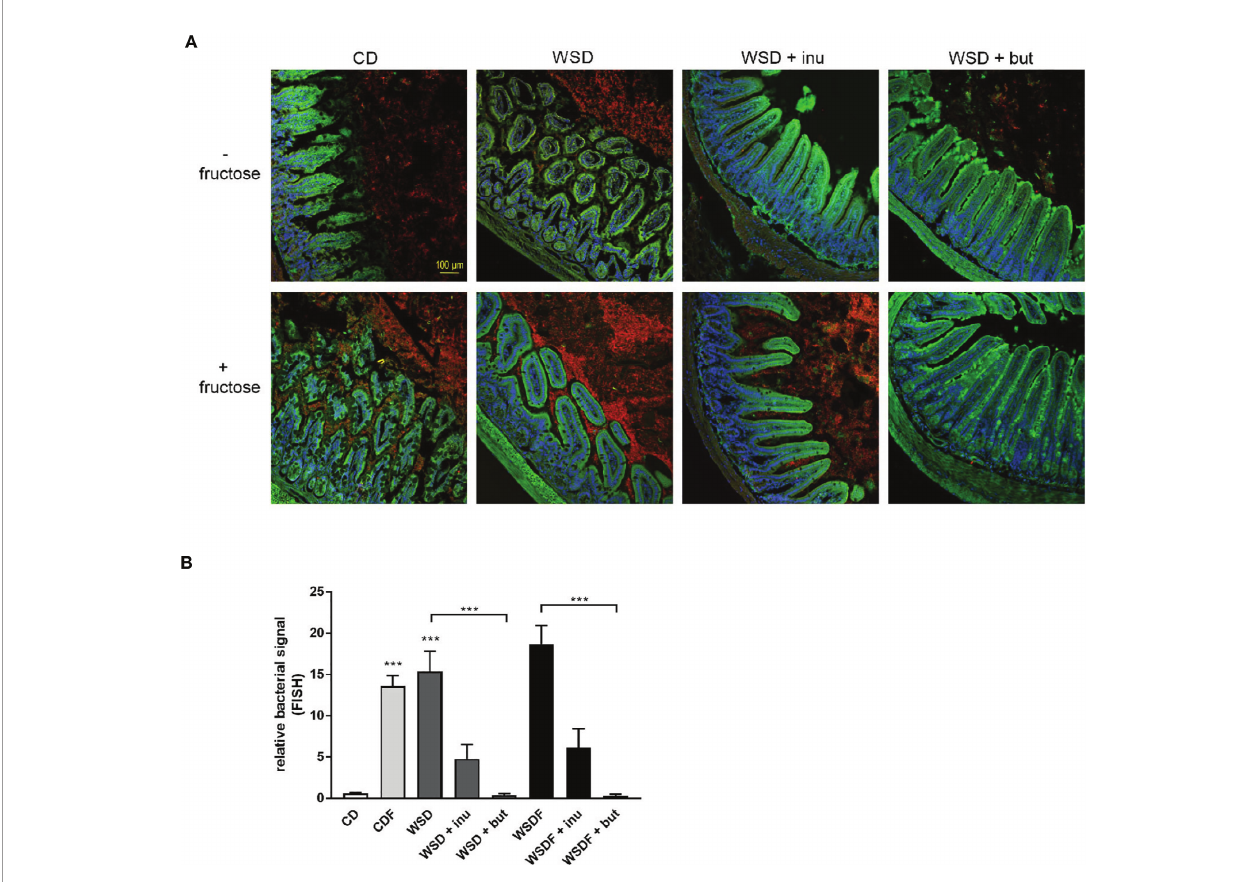
FIGURE 5 | Effects of inulin and sodium butyrate on small intestinal bacterial overgrowth (SIBO). C57BL/6 mice fed different diets as described in Figure 1 are shown. (A) Representative images of FISH staining in ileal tissue showing bacterial growth in red and cell nuclei detected by DAPI in blue. Scale bar: 100 µm. (B) Quanti fi cation of bacterial overgrowth. Data are presented as means +/- standard error of the mean (SEM). Statistical analysis was performed by one-way ANOVA with Kruskal-Wallis-test for non-parametric data with a Dunn ’ s post-test. Signi fi cant differences are indicated as ***p-value <